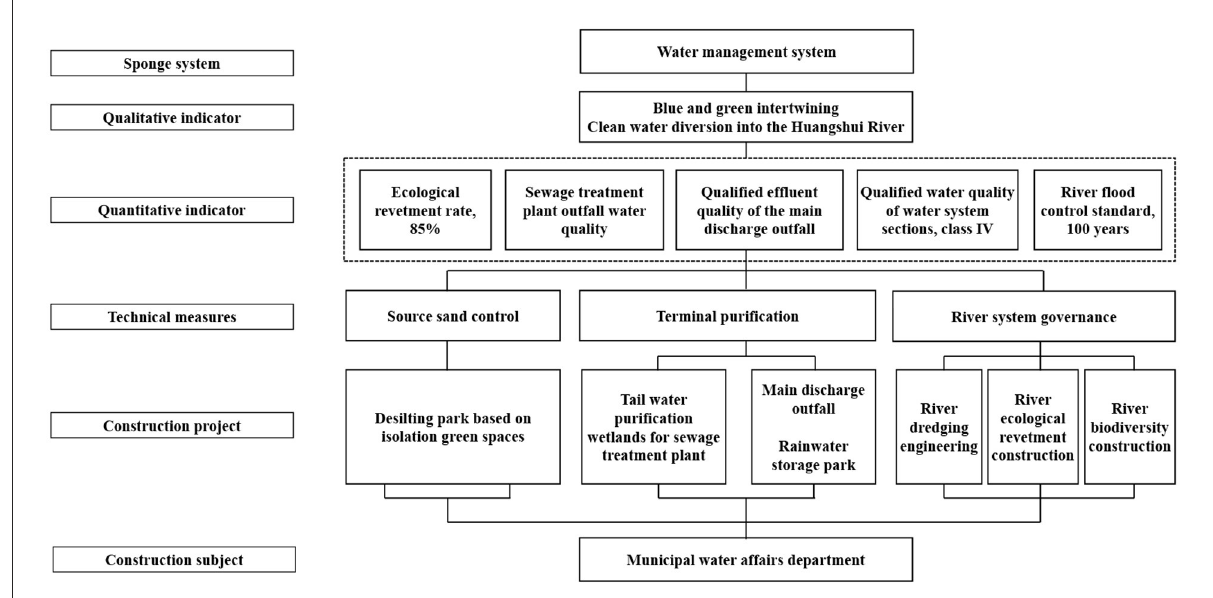
FIGURE10 Technical route of water management in the sponge city construction of Xining.